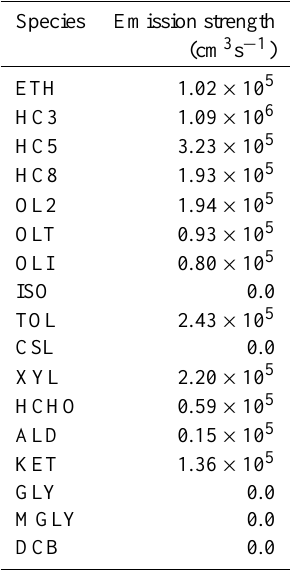
Table 5. Emission strength per RADM2 VOC species for scenario PLUME and scenario URBAN. The total VOC emission of 3 . 0 × 10 6 cm 3 s − 1 was segregated according to Kuhn et al. (1998) and Middleton et al.